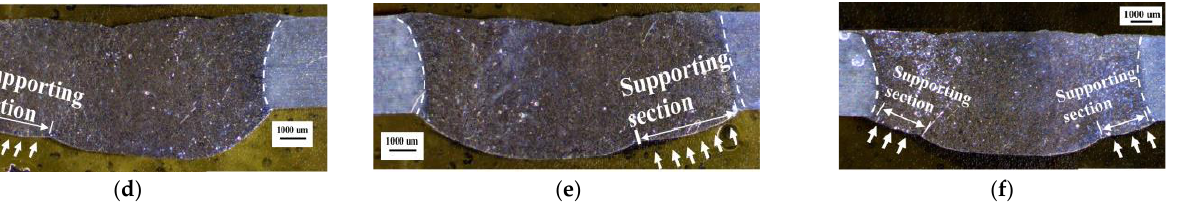
Figure 10. Profile of beads with different underlying supporting plate: ( a ) no supporting plate for 177 J/mm; ( b ) with supporting plate for 177 J/mm; ( c ) no supporting plate for 231 J/mm; ( d ) with supporting plate on the left for 231 J/mm; ( e ) with supporting plate on the right for 231 J/mm; ( f ) with supporting plate on both sides for 231 J/mm.